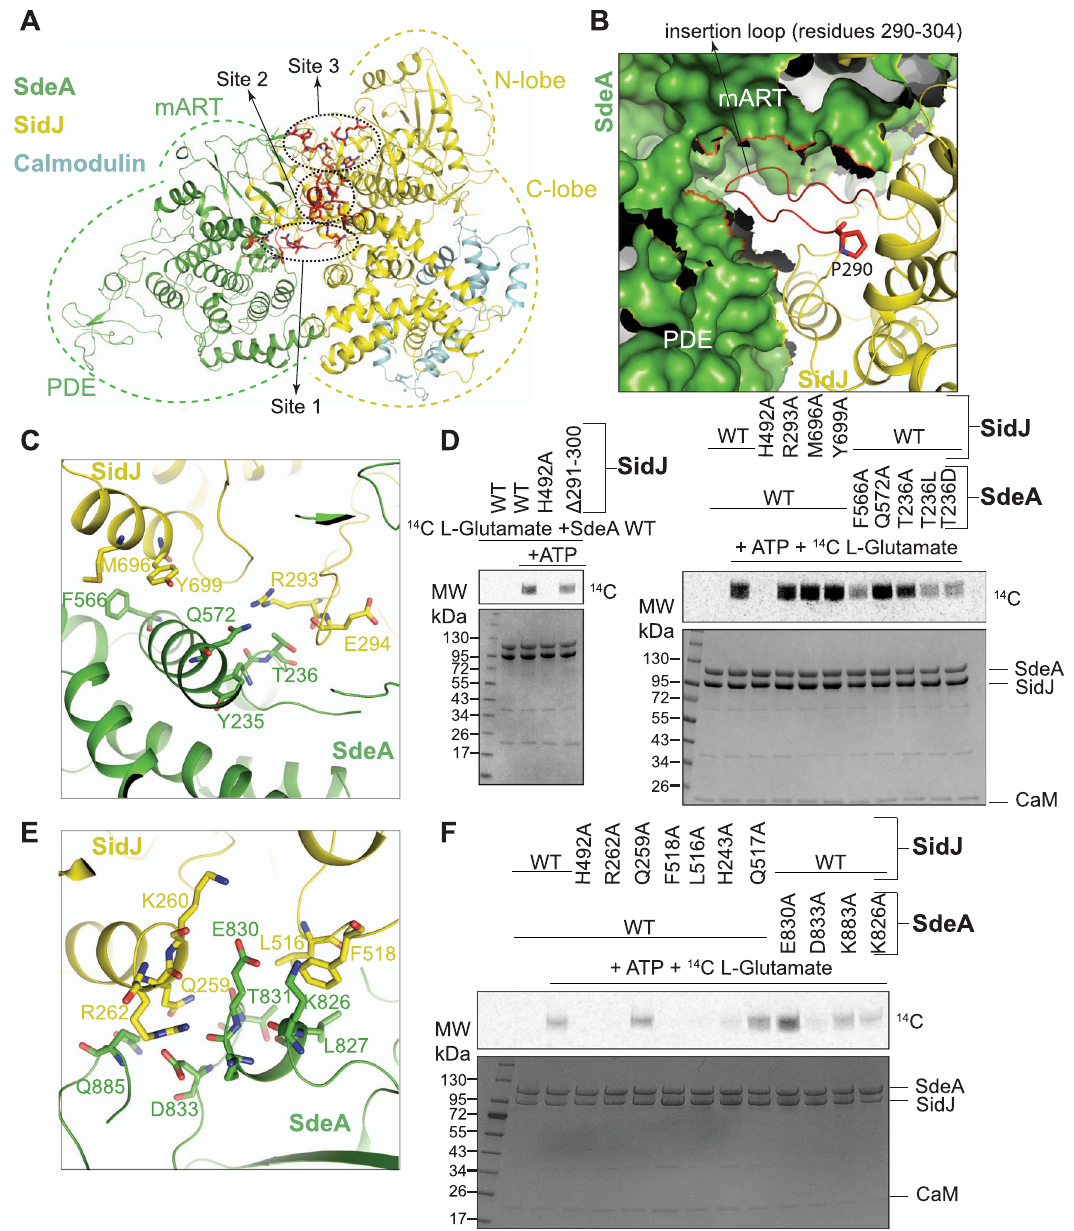
between SidJ and SdeA. Site 1 being the loop insertion site (Shown in 3B, C), site 2 being the mART site (Shown in 3E), and site 3 being the migrated